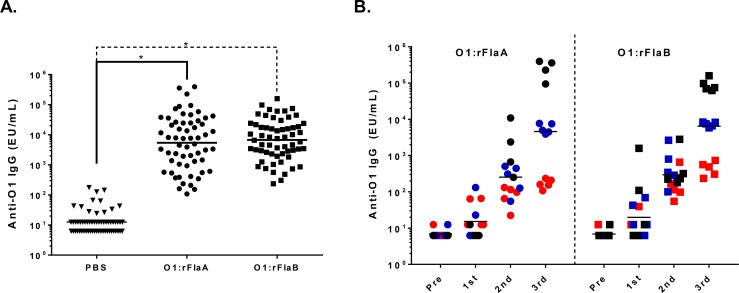
Immunogenicity and kinetics of anti-OPS IgG induced by monovalent KPO1 conjugates with PA rFlaA or rFlaB in mice.(A) Anti-OPS IgG was assessed in sera obtained 28 days after the last dose from mice (n = 59–60) immunized with three doses of PBS (triangles), O1:rFlaA (circles) or O1:rFlaB (squares). Statistical significance by Mann-Whitney is indicated. * P ≤ 0.0001. Each point indicates the serum titer from an individual mouse. Bars indicate the geometric mean titer. (B) Anti-OPS IgG titers in select high (black, n = 4–5), moderate (blue, n = 5) or low (red, n = 5) responders in sera taken directly prior to immunization or 14 days after the 1st, 2nd, or 3rd dose of O1:rFlaA (circles) or O1:rFlaB (squares). Bars indicate the geometric mean titer.